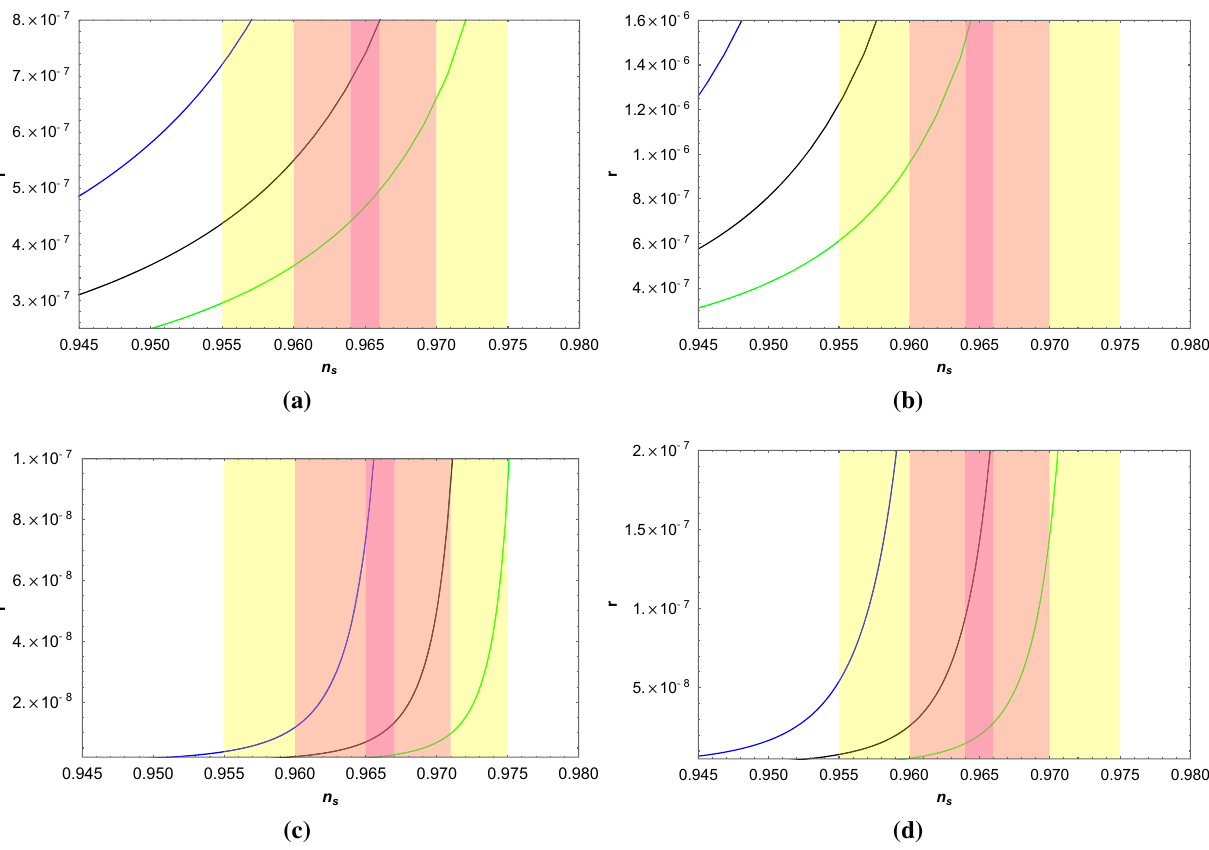
Fig. 2 Plots of r and n s as a function ρ 0 for fixed values of V 0 = 10 8 GeV. In a n = 1 , q = 2 and m = 10 − 6 , b n = 2 , q = 2 and m = 10 − 3 , c n = 3 , q = 2 and m = 10 − 3 and in d n = 4 , q = 2 and m = 10 − 3 . The blue line corresponds to N e = 55, the black line corresponds to N e = 65, the green line corresponds to N e = 75 .